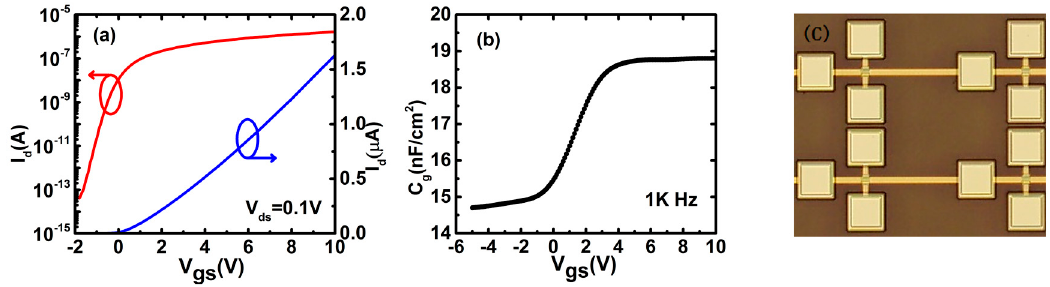
Figure 2. Experimental data of IZO TFTs ( W / L = 20 μ m/10 μ m). ( a ) Transfer characteristics; ( b ) C g –V gs characteristics; ( c ) The micrograph of the devices.